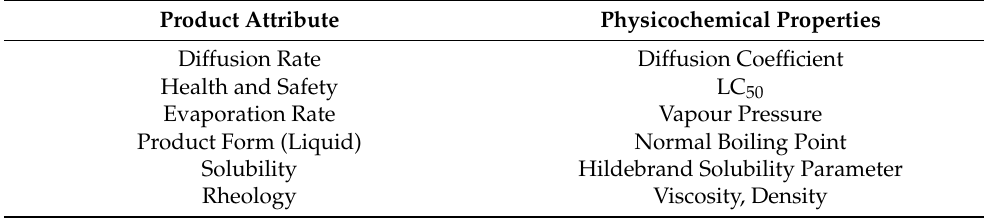
Table 1. Fragrance molecule attributes.